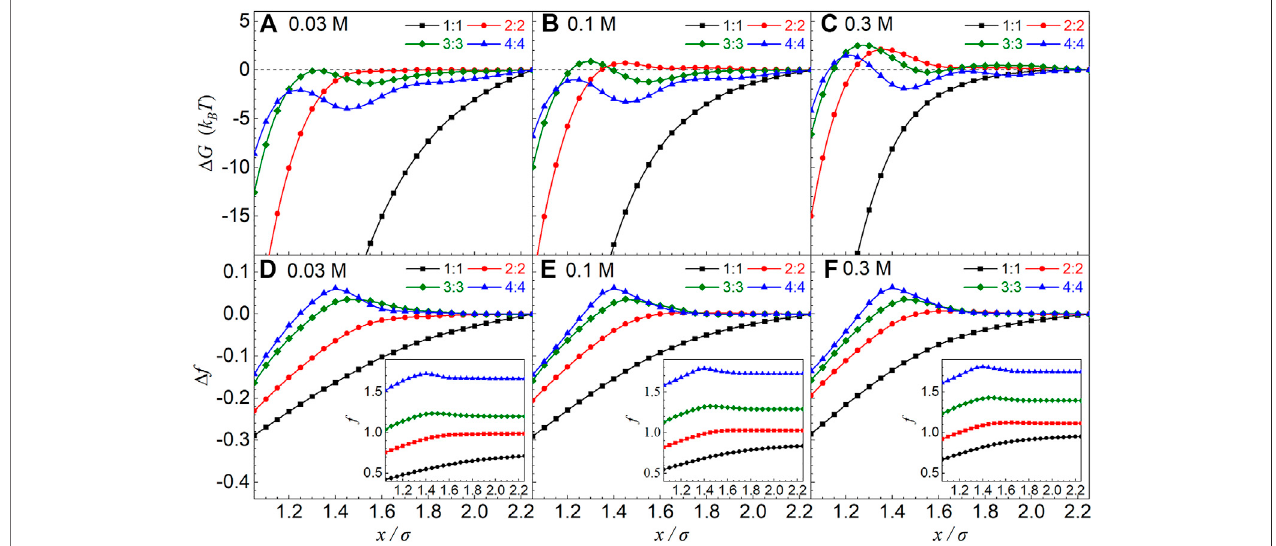
FIGURE2|(A – C) Effectivepotentialsofmeanforce Δ G(x)betweenequallyandoppositelychargedparticleswith|Z| (cid:1) 36einsymmetrical1:1,2:2,3:3,and4:4salt solutions from the MC simulations. (D – F) The relative charge fraction Δ f (cid:1) f(x) − f(x ref ) of condensed counterions obtained from the MC simulations as a function of separation x between two oppositely charged particles. The insets are the charge fraction f(x). The salt concentrations and ion valences have been shown in the respective panels. The reference separation was taken as x ref (cid:1) 45